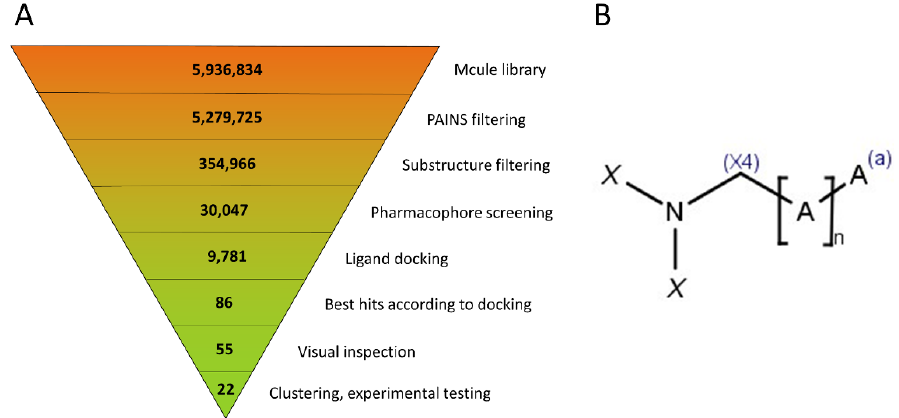
Figure 3. ( A ) Virtual screening workflow, with the number of compounds at each step